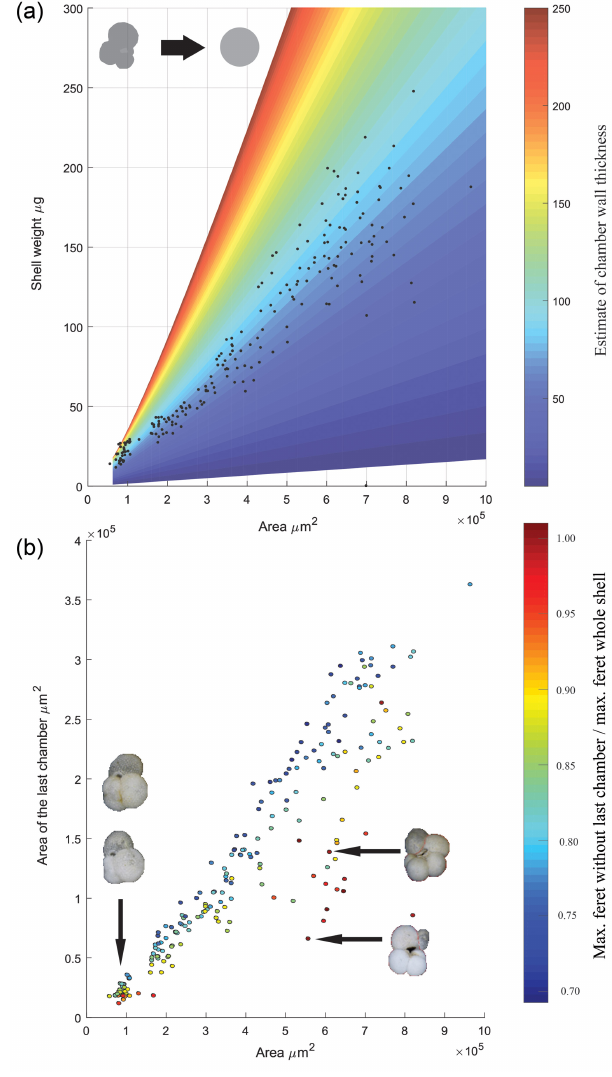
Figure 4. Physical properties of T. sacculifer . (a) Size vs. weight of T. sacculifer ; the data are overlaid on a theoretical calculation of what the shell weight would be of a spherical hollow foraminifer with consistent porosity, assuming the density of calcite. Colour represents variation in wall thickness used to calculate the differ- ence between the inner and outer sphere volume. (b) The area of the final chamber vs. the whole shell area of specimens measured, pictures inset highlight the morphology associated with the spread in the datasets. The scatter points filled colour reflects the ratio between the maximum ferret diameter with and without the last chamber. The linear regression equation is y = 0 . 0002 x − 4 . 5243 ( r 2 = 0 . 8985; n =